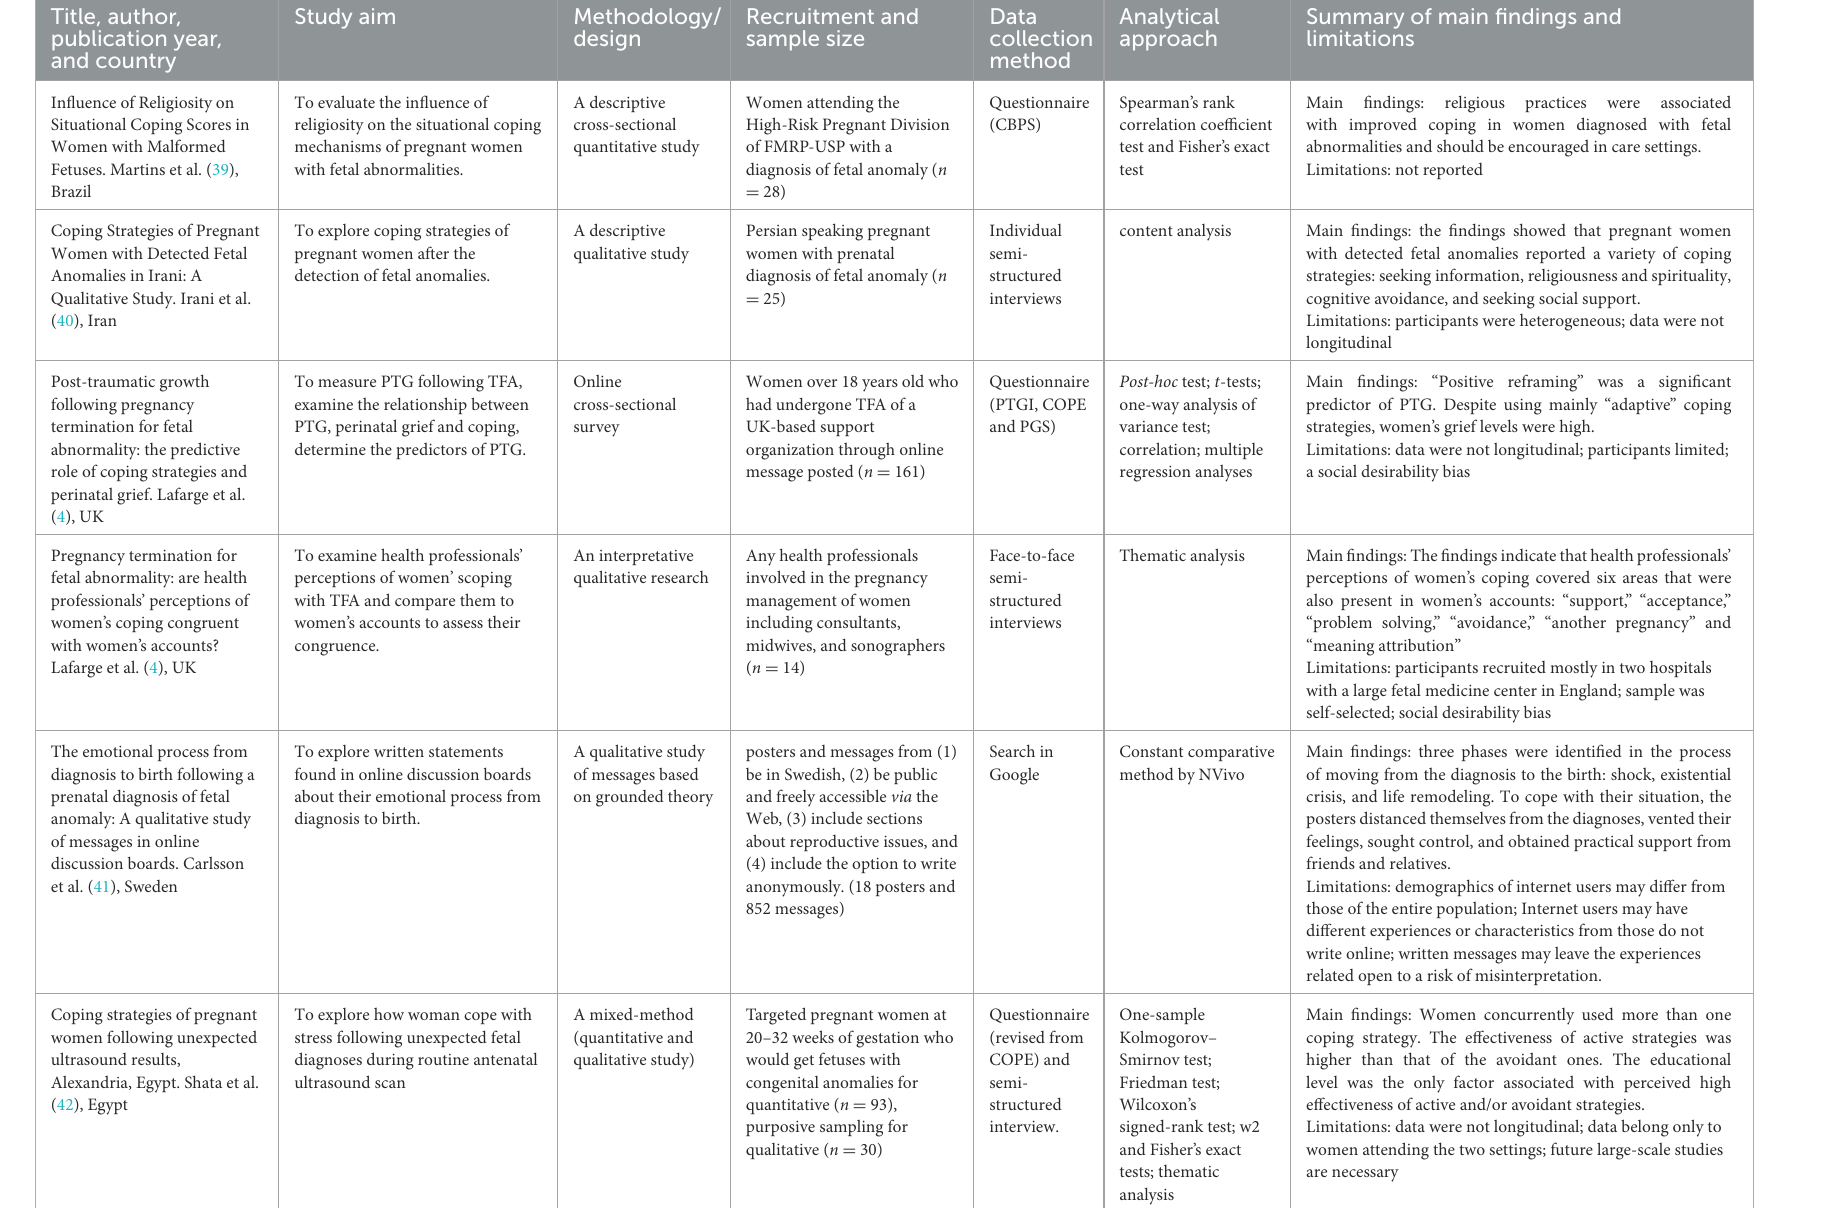
TABLE 2 Individual characteristics of the included studies ( n = 16) on coping strategies of the women diagnosed with a fetal